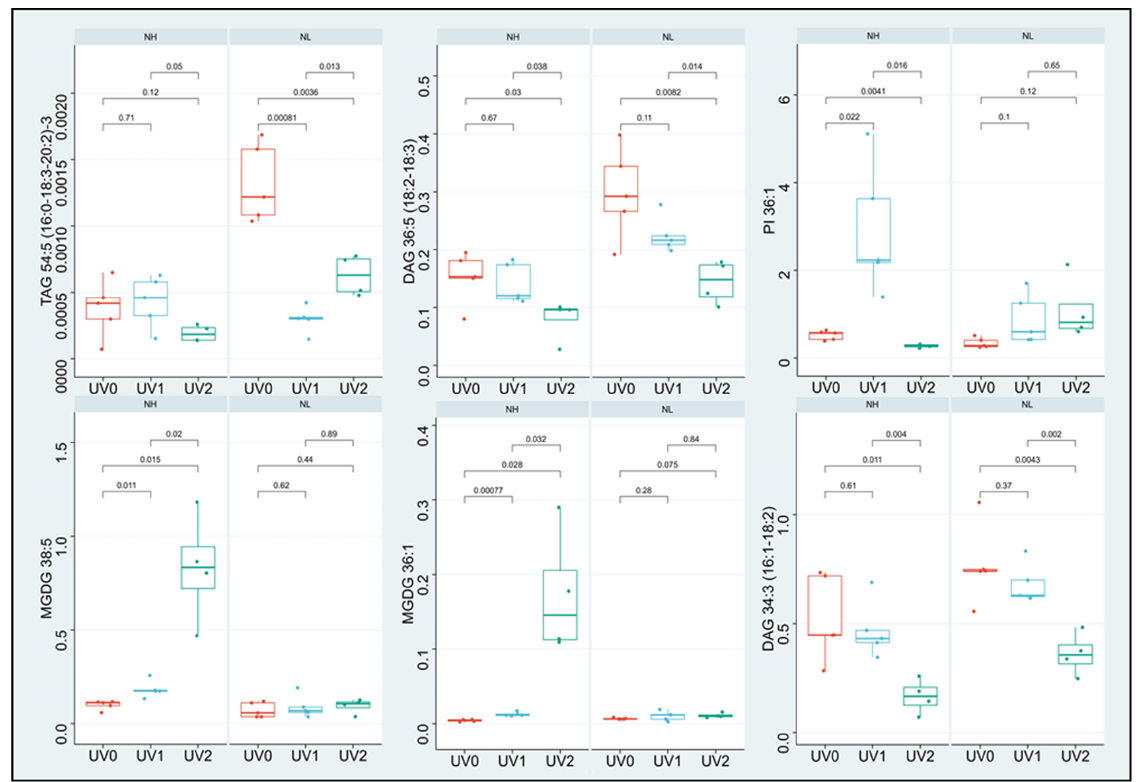
Figure 5. Six lipids with the most significant changes in tea leaves were screened according to PLS- DA